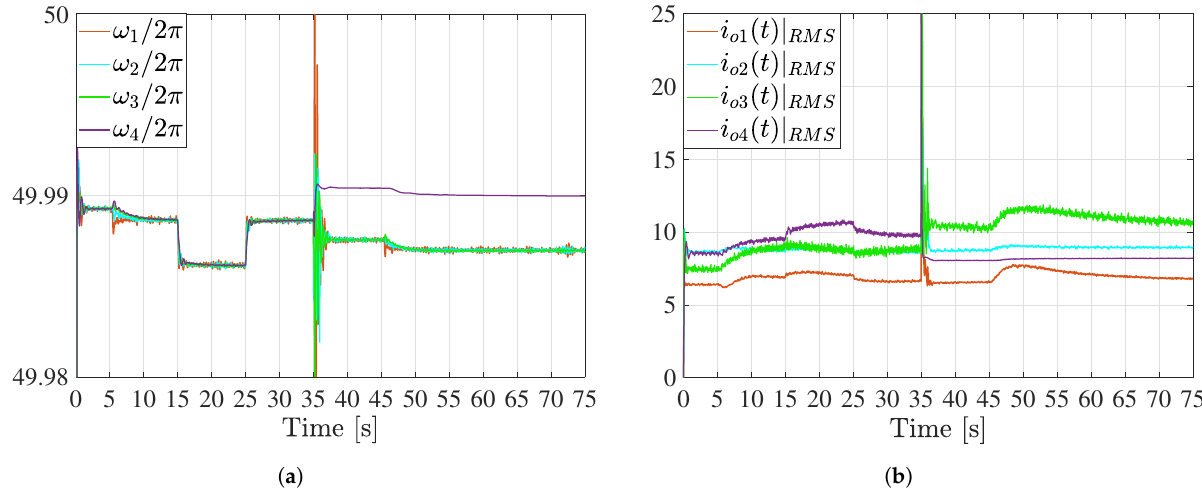
Figure 3. ( a ) Frequencies of the DG’s output voltages measured by 3-phase Phase Locked Loop sensors; ( b ) RMS inverters’ output